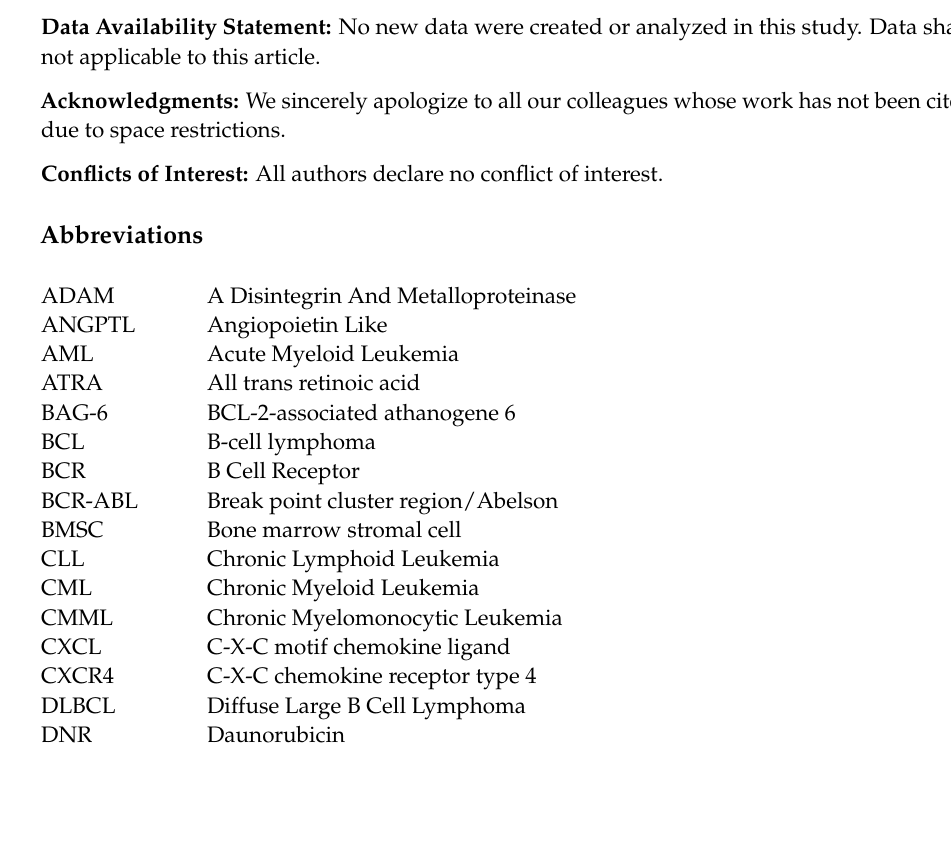
angiogenesis promotion, Table S6: Summary of current studies on EVs: immune evasion, Table S7: Summary of current studies on EVs: hypercoagulability, Table S8: Summary of current studies on EVs: drug